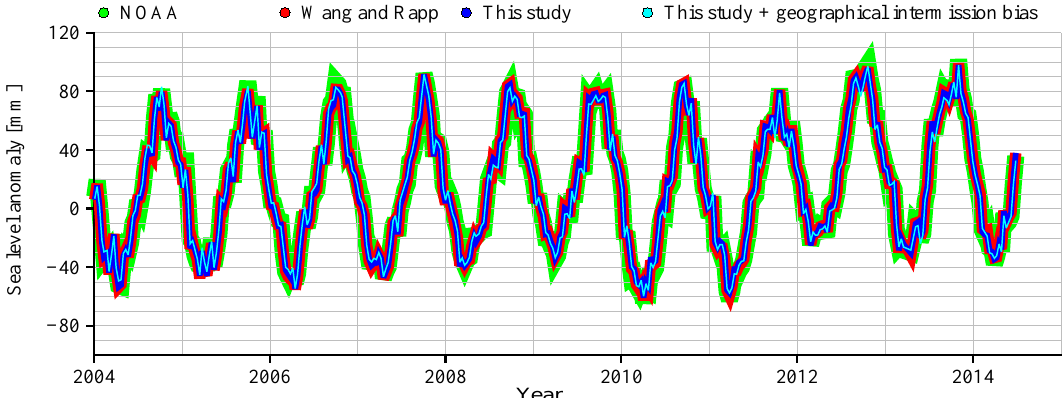
Figure 3. Comparison between North Atlantic mean sea level time series of NOAA (green), the Wang and Rapp method (red), our method (blue) and our method using a geographically dependent intermission bias correction and the latest geophysical corrections (light